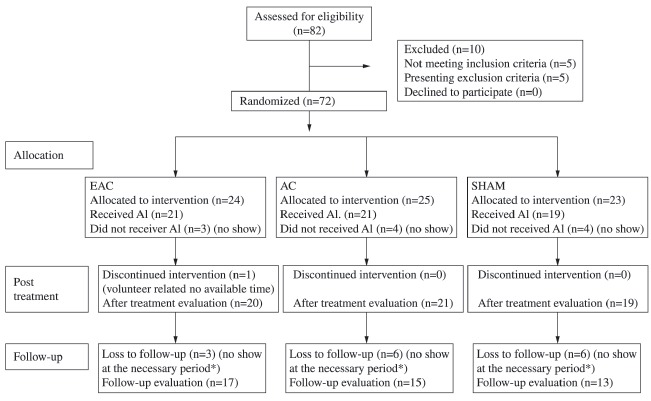
Enrollment of participants and study design. Al = Allocated intervention;
*refers to menstrual cycle period.